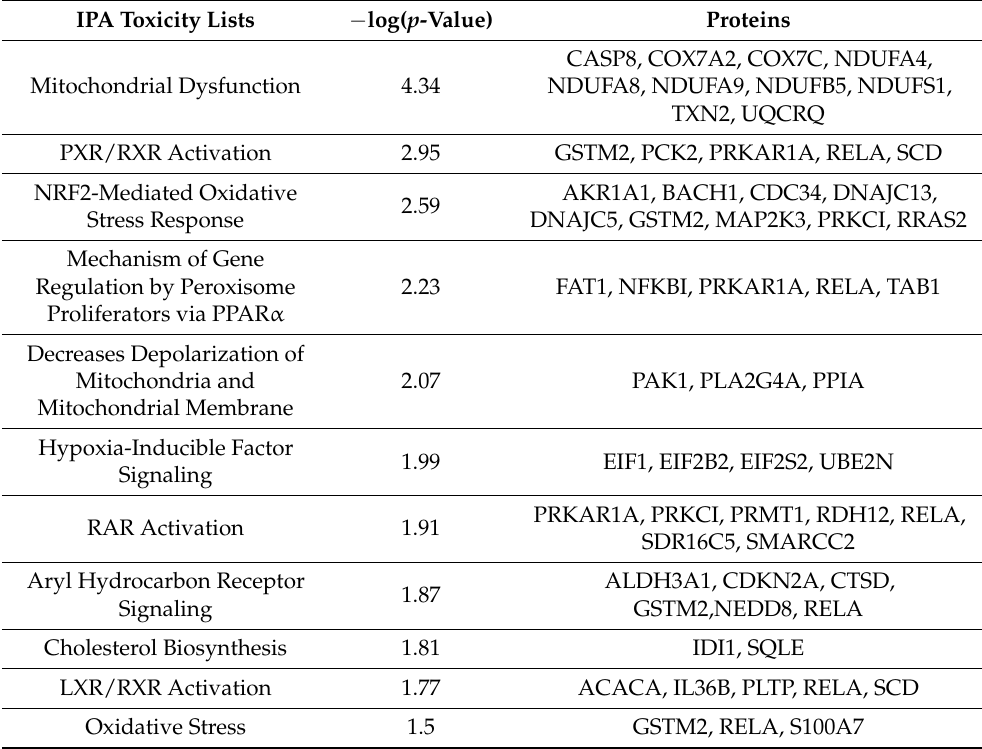
Table 6. Toxicity lists for the 400 µ g/mL of nicotine vs. PBS